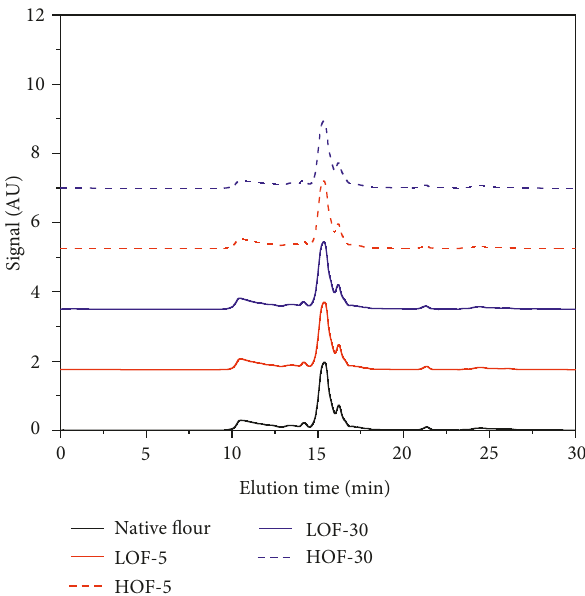
Figure 2: SE-HPLC chromatograms for extractable proteins of native and ozone-treated wheat flours. LOF-5: wheat flour treated at low-intensity condition for 5min; LOF-30: wheat flour treated at low-intensity condition for 30min; HOF-5: wheat flour treated at high-intensity condition for 5min; HOF-30: wheat flour treated at high-intensity condition for